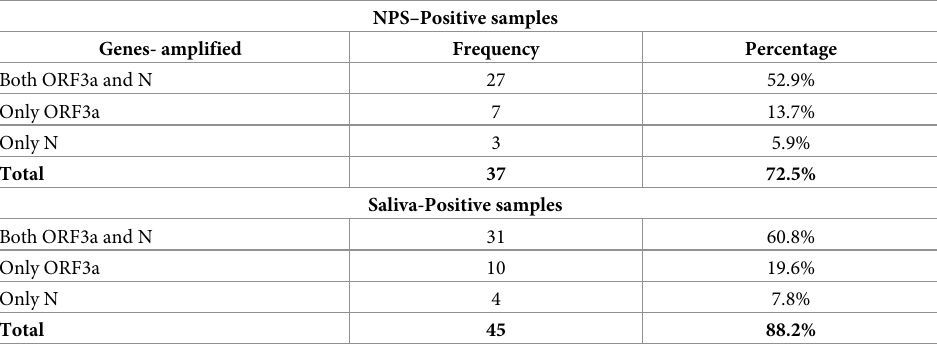
Table 5. Positive NPS and saliva samples when both ORF3a and N genes amplified vs when only N gene amplified for comparative evaluation of saliva and NPS for SARS-CoV-2 detection using RT-PCR among COVID-19 sus- pected patients at Jigjiga, Eastern (n =